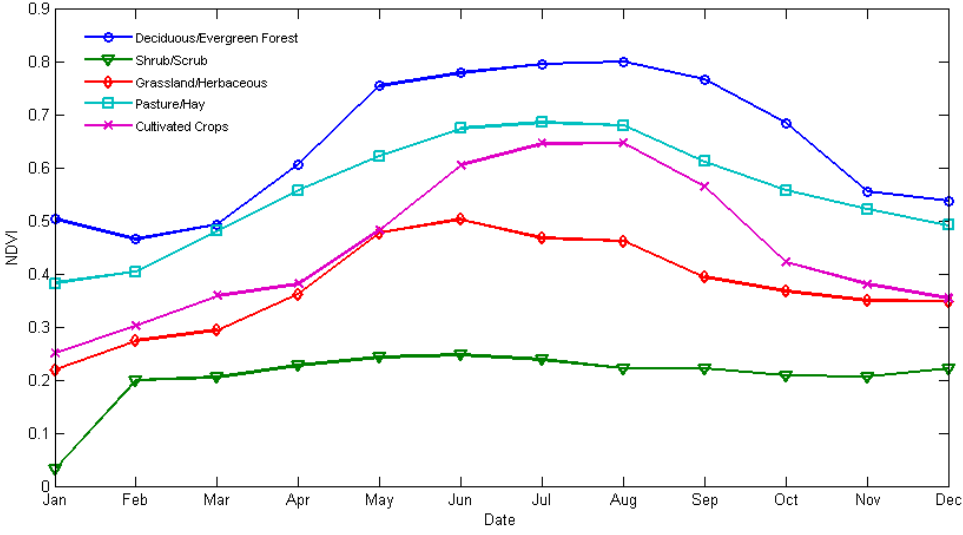
Figure 14. The temporal variation of averaged NDVI for sampling sites in different land covers.